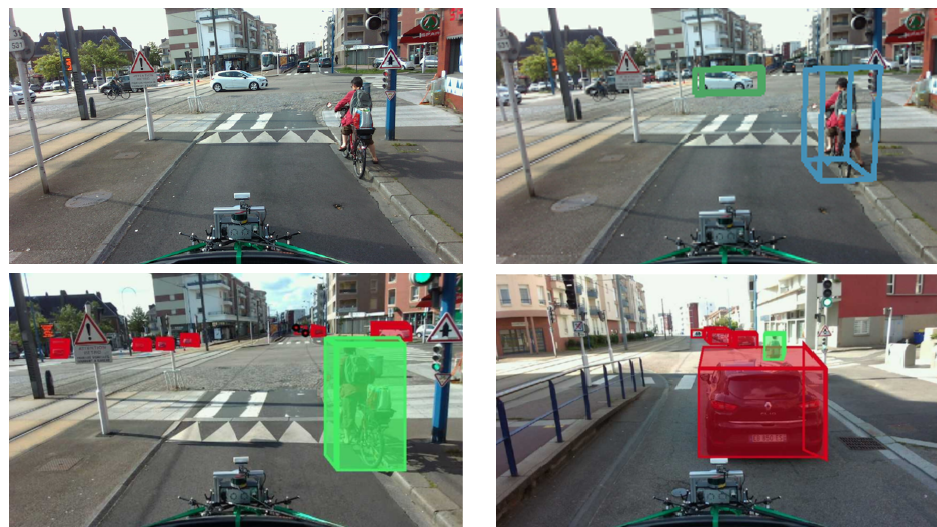
Figure 14. Examples of images annotations in Rouen city center (France). Top level left : regular image without any annotations, top level right : image with annotations for two classes: car and cyclist, acquired in Rouen city center. Bottom up level left : 3D bounding box for two classes: car (in red color) and cyclist (green color), bottom up level right : 3D bounding box for two classes: car (in red color) and cyclist (green